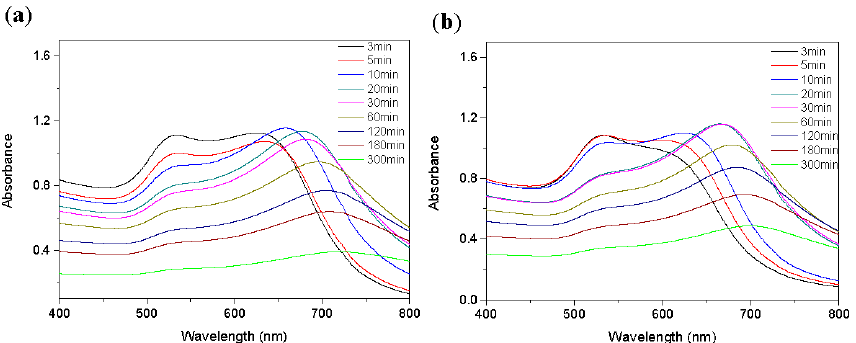
Figure 7. Detection times for ( a ) Ace and ( b ) Nap.